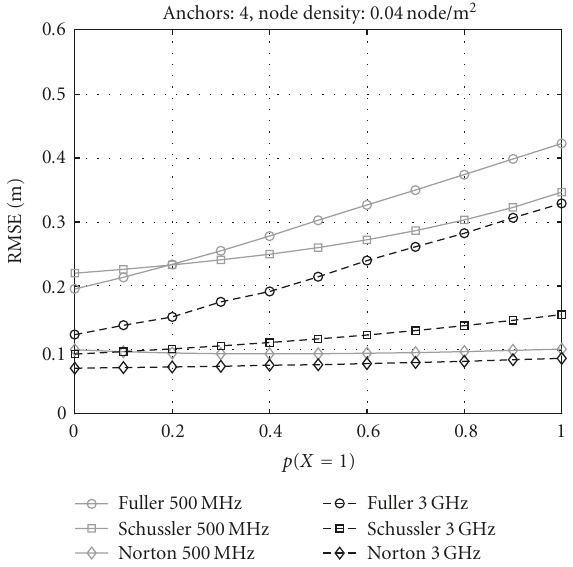
Figure 9: Localization performances as a function of DP blockage probability, p ( X = 1), for 500 MHz and 3GHz